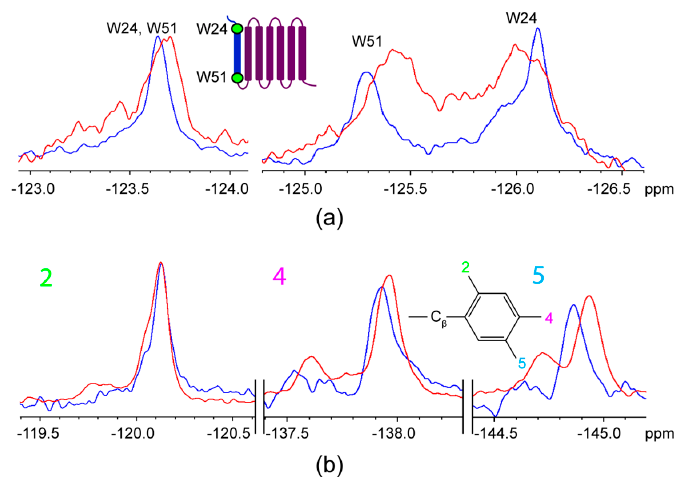
Figure 6. 19 F NMR spectral regions corresponding to ( a ) F-Trp labelled AR55 and ( b ) F*-ap-13. Experiments are compared for each species alone (blue) and at excess AR55 (red; ~4:1 AR55:F*-ap-13; an equimolar mixture of AR55 labelled with 4F-Trp (~125 ppm) and 6F-Trp (~123.7 ppm)).